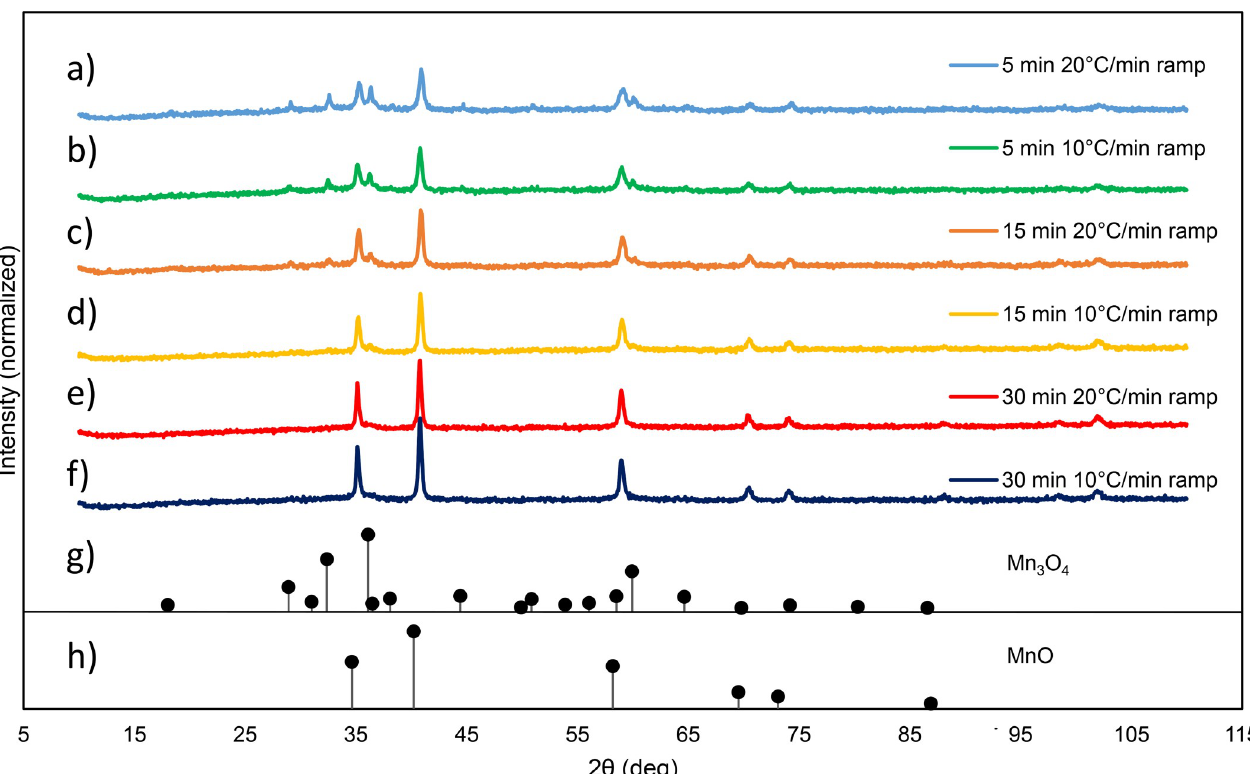
Fig 4. XRD spectra of Mn 3 O 4 /MnO NP mixture or MnO NPs generated with the following temperature profiles: a) 5 min at 300˚C with 20˚C/min ramp, b) 5 min at 300˚C with 10˚C/min ramp, c) 15 min at 300˚C with 20˚C/min ramp, d) 15 min at 300˚C with 10˚C/min ramp, e) 30 min at 300˚C with 20˚C/min ramp, and f) 30 min at 300˚C with 10˚C/min ramp. The standard diffraction peaks for known g) Mn 3 O 4 and h) MnO are shown from X’Pert HighScore. Upon comparison with the standard spectra, a-c) shows Mn 3 O 4 /MnO NP mixtures, whereas d-f) shows MnO NPs.